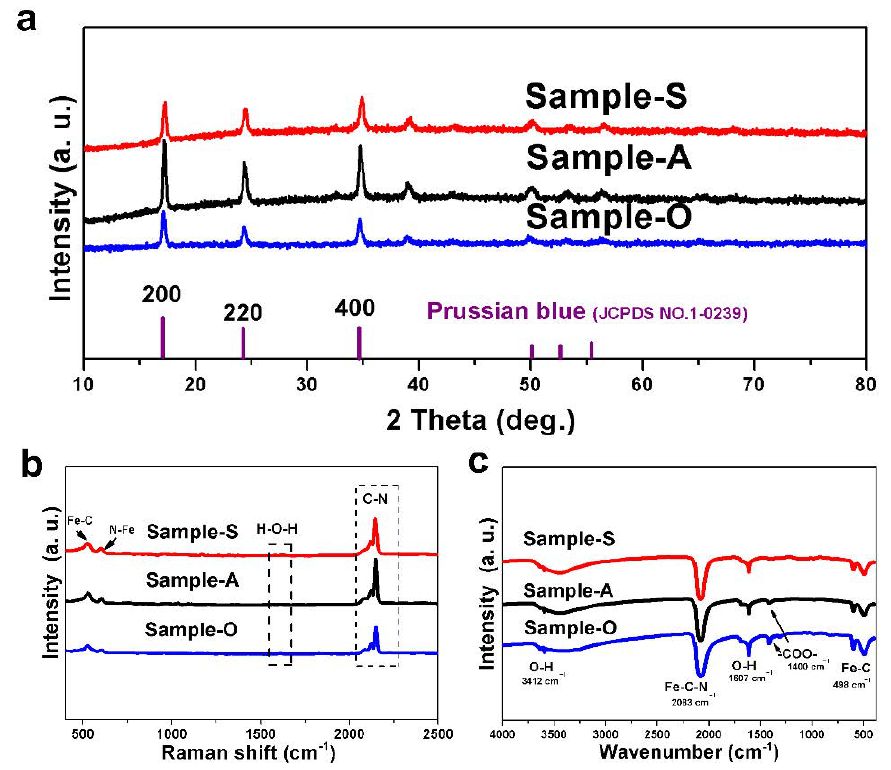
Figure 1. ( a ) XRD patterns of all the samples. ( b ) Raman test of all the samples. ( c ) Fourier transform infrared spectroscopy of all the